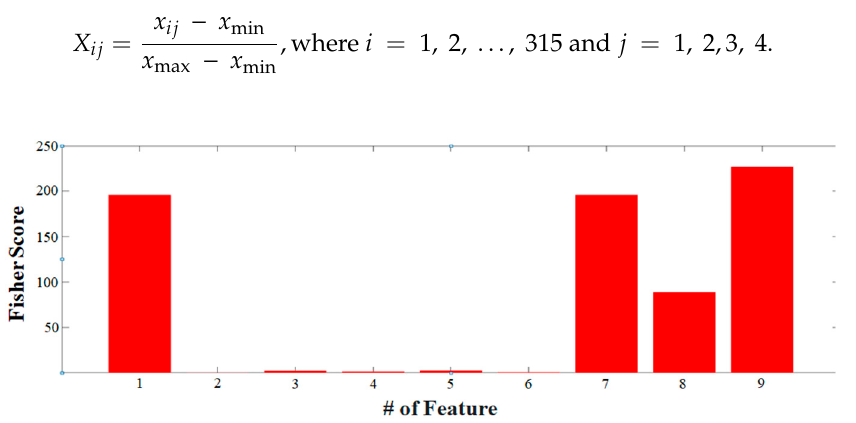
Figure 9. Fisher scores for nine features.